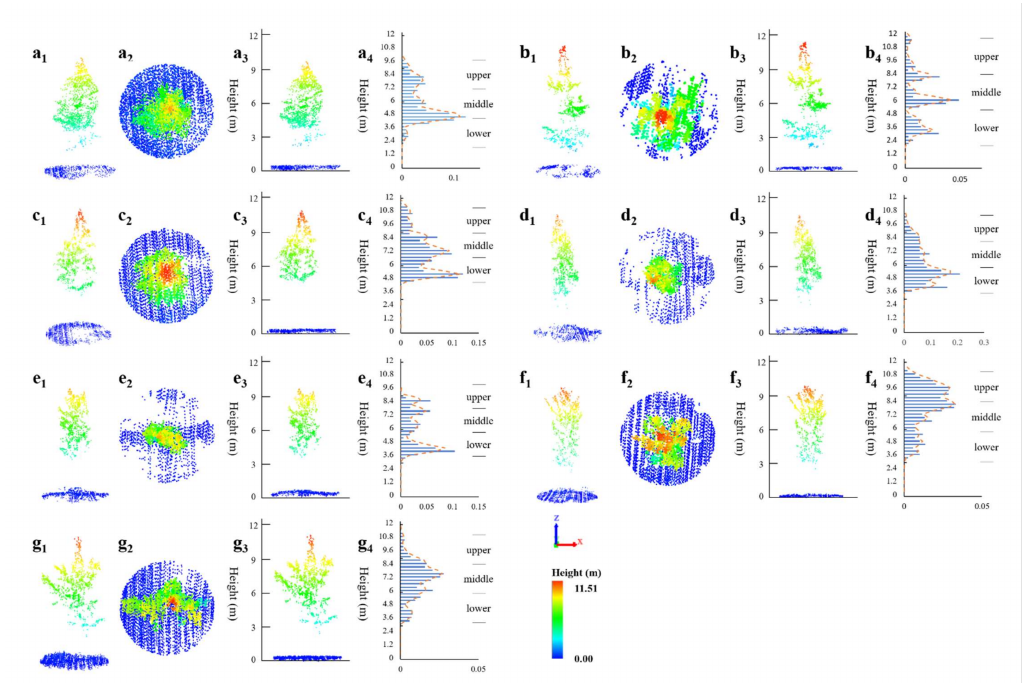
Figure 5. Point cloud visualization and cross-sectional structure diagram of seven sampling